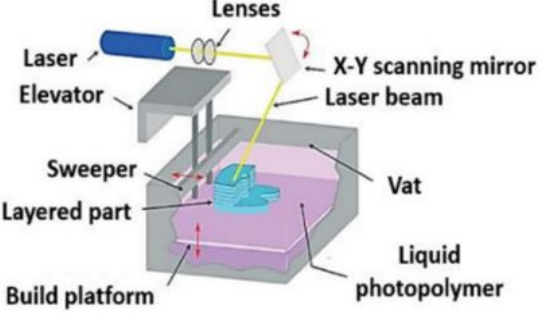
Figure 15. Three-dimensional (3D) printer apparatus scheme [59]. Open access, Copyright MDPI.